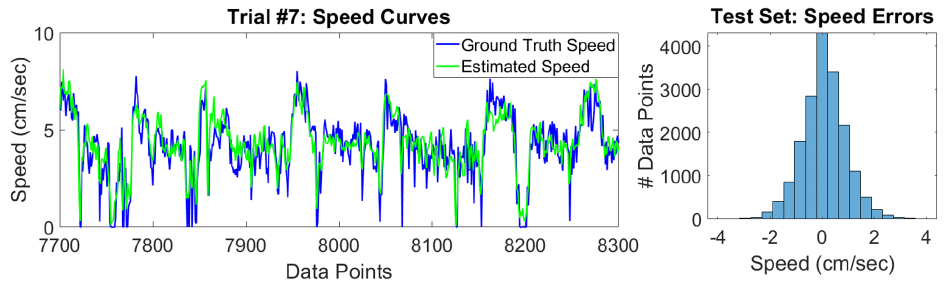
Figure 10. Test Set Speed Errors: ( Left Plot ) A five-minute section of Trial #7’s speed curve is shown, where the estimated and ground truth speeds are compared. ( Right Plot ) Distribution of the speed errors between the estimated and ground truth speeds. Each bin has a width of 0.4 cm/s. Table 6. Performance of speed estimation